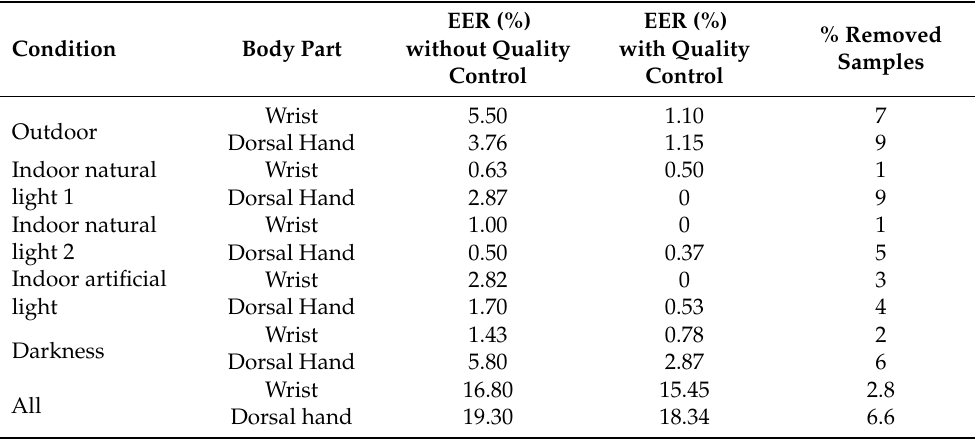
Table 6. Recognition performance after removing samples by genuine score-based